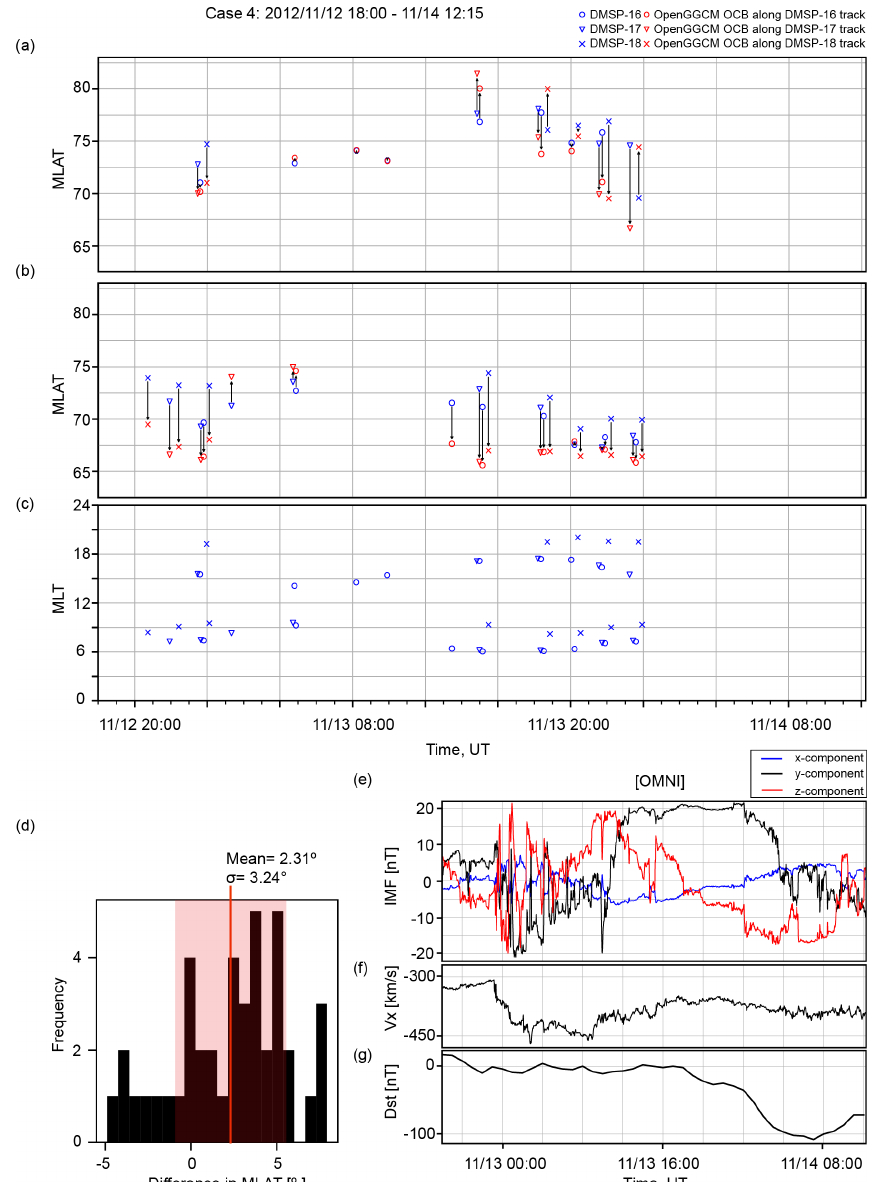
Figure 4. Comparison between the observed and simulated OCB latitudes for 13 November 2012 event in the same format as Fig.